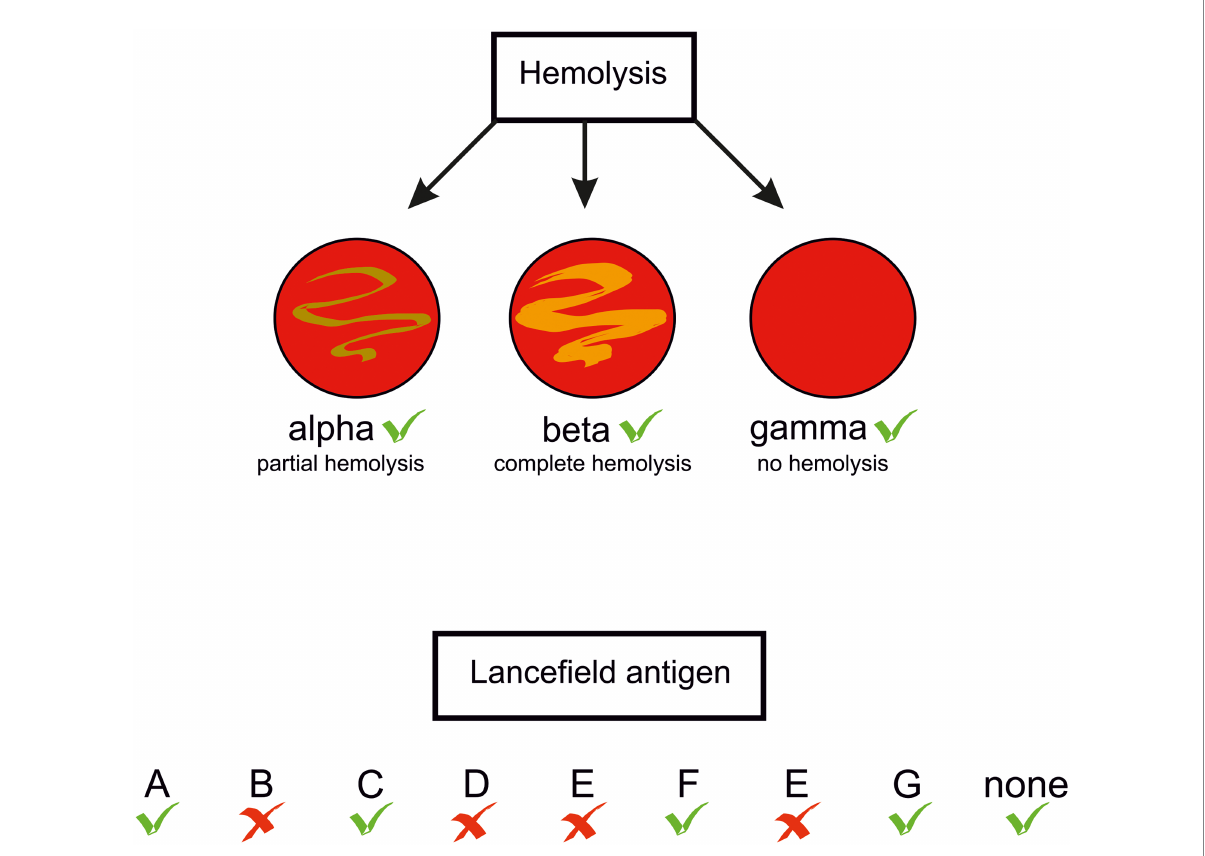
FIGURE 1 Types of hemolysis and Lancefield antigens presented by S. anginosus strains. Green tick –feature present in some S. anginosus strains, red cross –